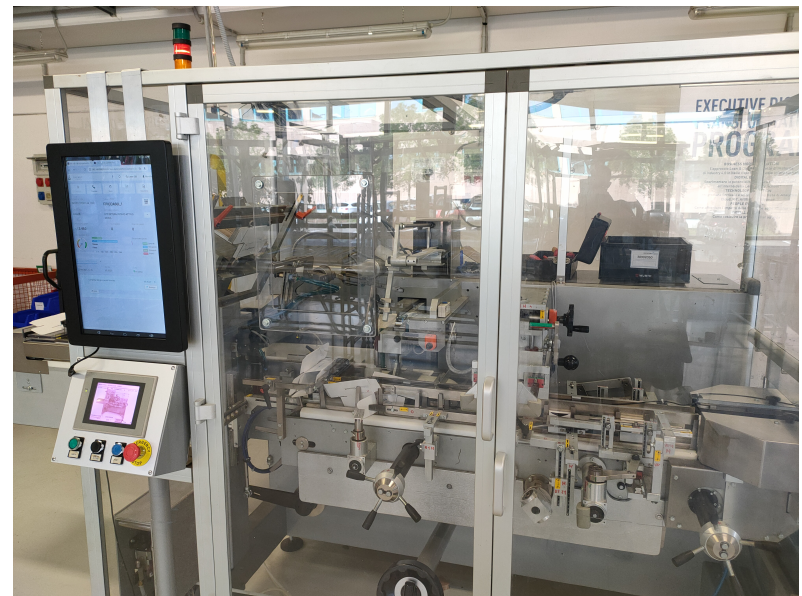
Figure 5. Production